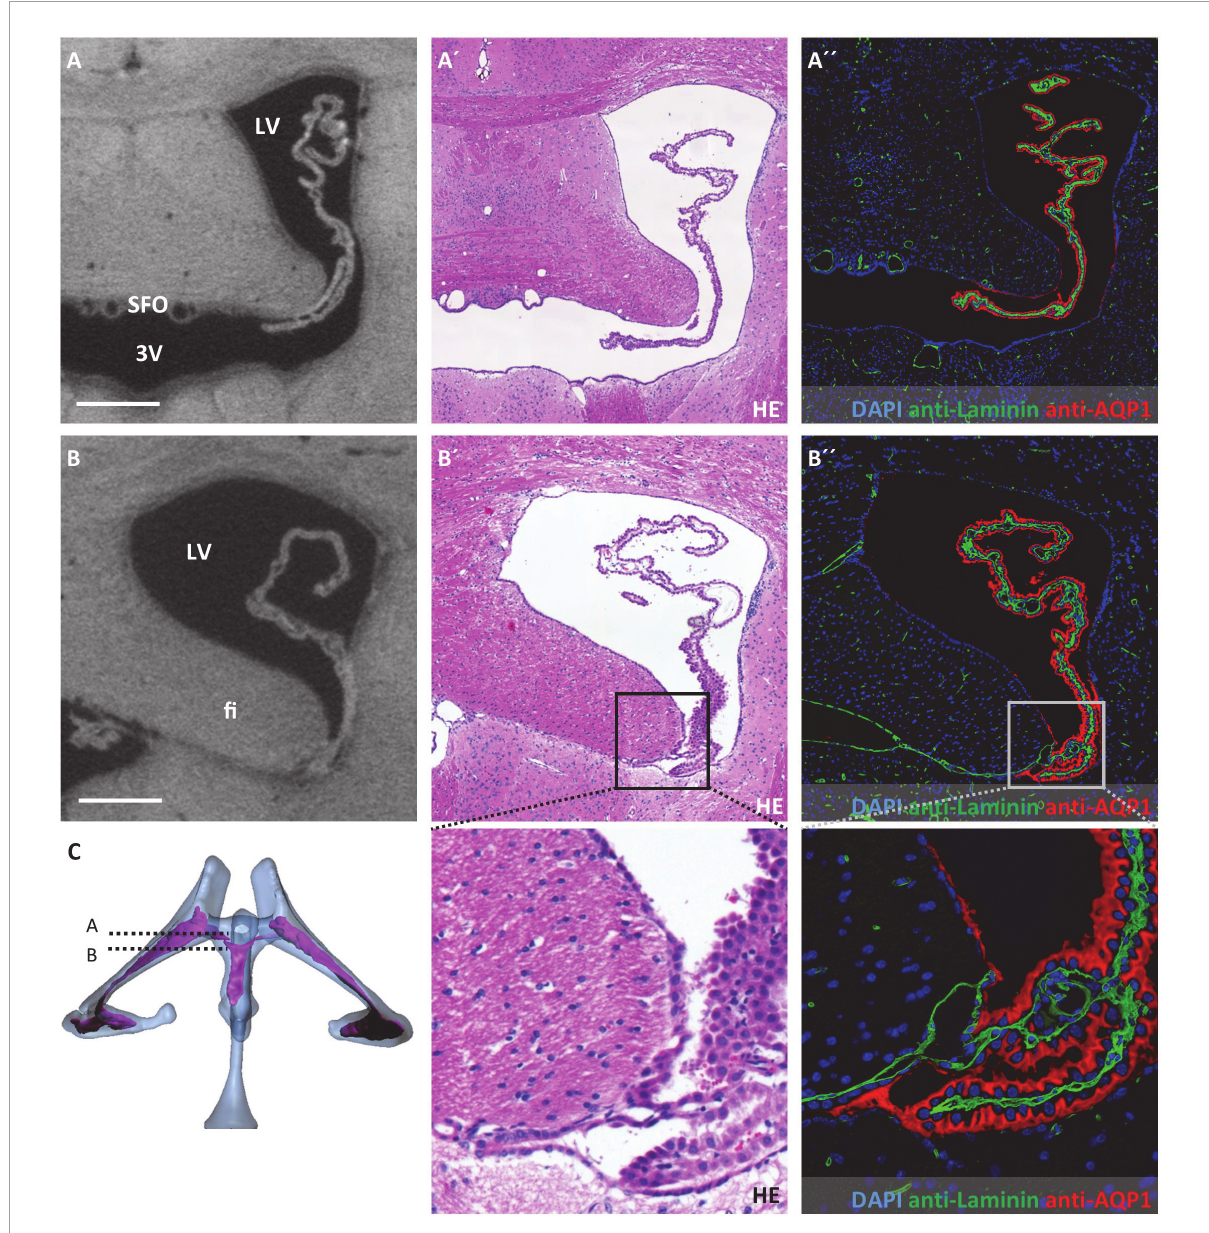
FIGURE3 Attachment regions of the choroid plexus in the lateral ventricle. On the left, virtual sections from micro-computed tomography scans; in the middle, hematoxylin-eosin staining; and on the right, immunofluorescence double labeling with anti-laminin (green), anti-aquaporin1 (AQP1, red), and nuclear staining with 4 (cid:48) ,6-diamidino-2-phenylindole (DAPI, blue). (A–A”) Coronal section at the level of the interventricular foramen that connects the lateral ventricle and third ventricle, the subfornical organ is located at the roof of the third ventricle, the choroid plexus is neither attached at the level of the interventricular foramen nor rostral to it; (B–B”) attachment of the choroid plexus occipital to the interventricular foramen, the epithelium of the choroid plexus transitions into the ependyma at the tip of the fimbriae hippocampi, the basal laminae pass along between the fimbriae hippocampi and diencephalon as seen in (B”) , below (B’,B”) enlargements of the attachment site; (C) illustration of sectional planes based on three-dimensional reconstruction of ventricular system with choroid plexus. Scale bars in (A,B) 200 µ m. LV, lateral ventricle; 3V, third ventricle; fi, hippocampal fimbria; SFO, subfornical